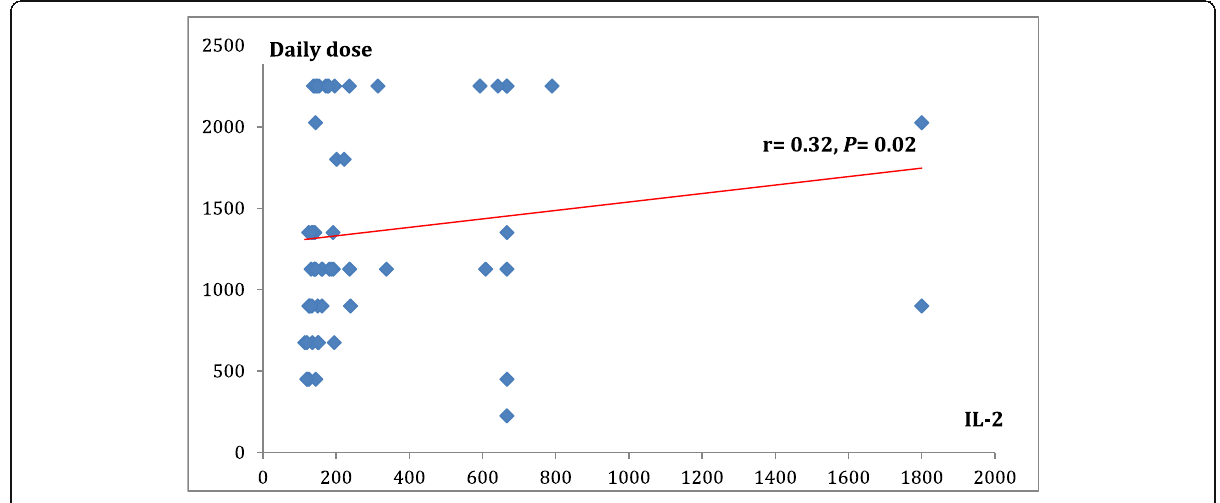
Fig. 2 Correlation between serum level of IL-2 and daily dose of